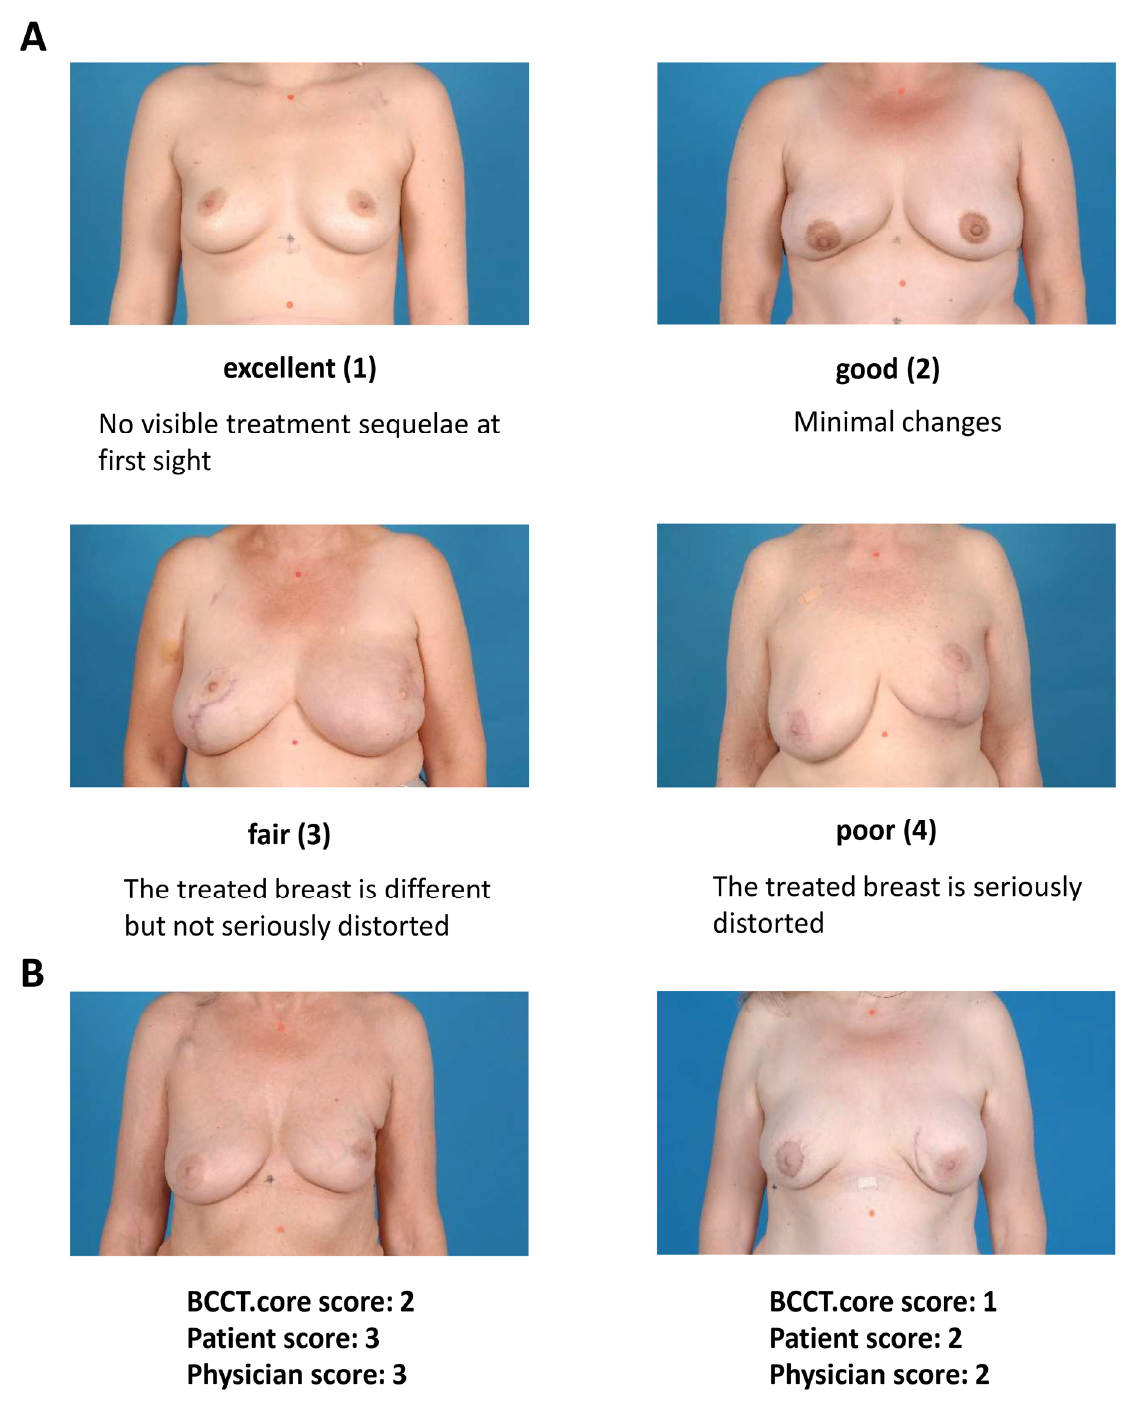
Figure 1. Esthetic results assessed with BCCT.core. Representative examples of excellent outcome, good outcome, fair outcome, and poor outcome, with agreement of the BCCT.core software results with patients’ and physicians’ assessment scores shown together with the definition of the Harvard Scale ( A ), as well as representative examples of disagreement ( B